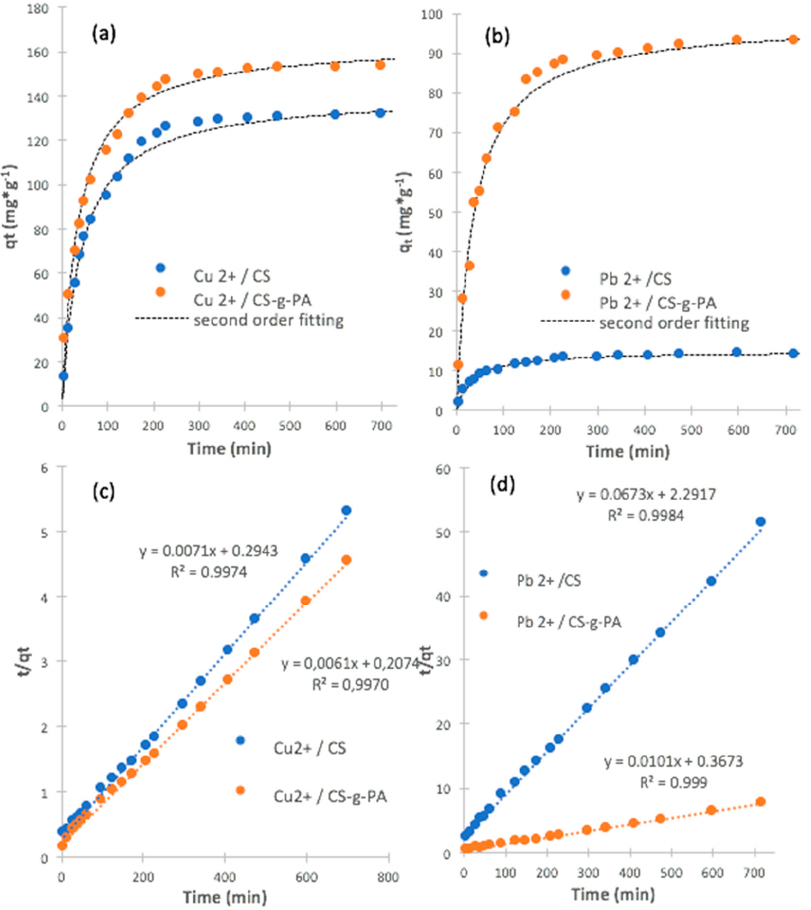
Figure 5. ( a ) Kinetic adsorption plots for Cu 2+ on CS and CS- g -PA; ( b ) Kinetic adsorption plots for Pb 2+ on CS and CS- g -PA; ( c ) linear fitting for Cu 2+ on CS and CS- g -PA; ( d ) linear fitting for Pb 2+ on CS and CS- g -PA; (initial concentration of Pb (II) and Cu (II) = 200 mg/L; pH = 4.0; adsorbent = 25 mg; volume of solution = 50 mL; temperature = 25 °C).